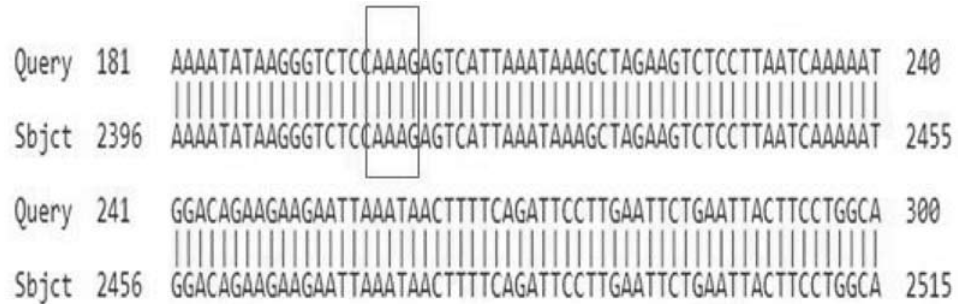
Fig. 6. Sequence analysis using BLASTn